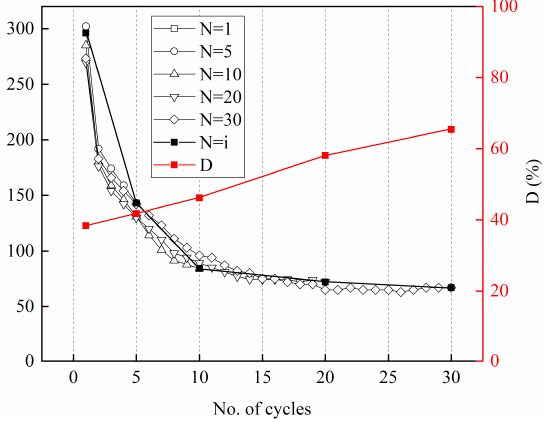
Figure 19. Surface image of the frozen cement-treated sand specimen after testing. ( a ) Division of the surface; ( b ) smooth area; ( c ) rough area.